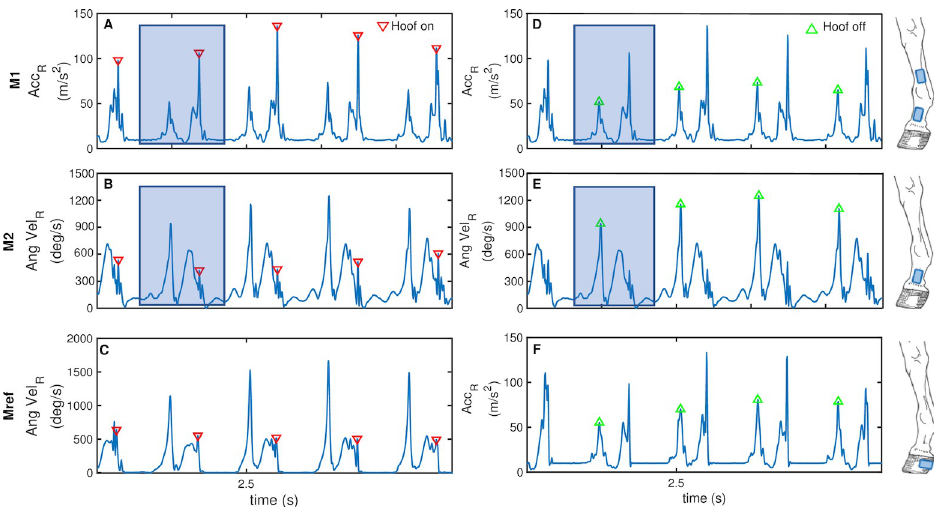
Fig 3. Illustration of the novel methods. Novel methods M1 (A and D) and M2 (B and E), and reference method M ref (C and F) are illustrated; blue windows are examples of the frames in which relevant peaks were sought; down triangles (A-C) indicate hoof-on and up triangles (D-F) hoof-off; the sensor locations (hooves, pasterns and/or cannons) for which each method is applicable are shown in illustrations on the right.